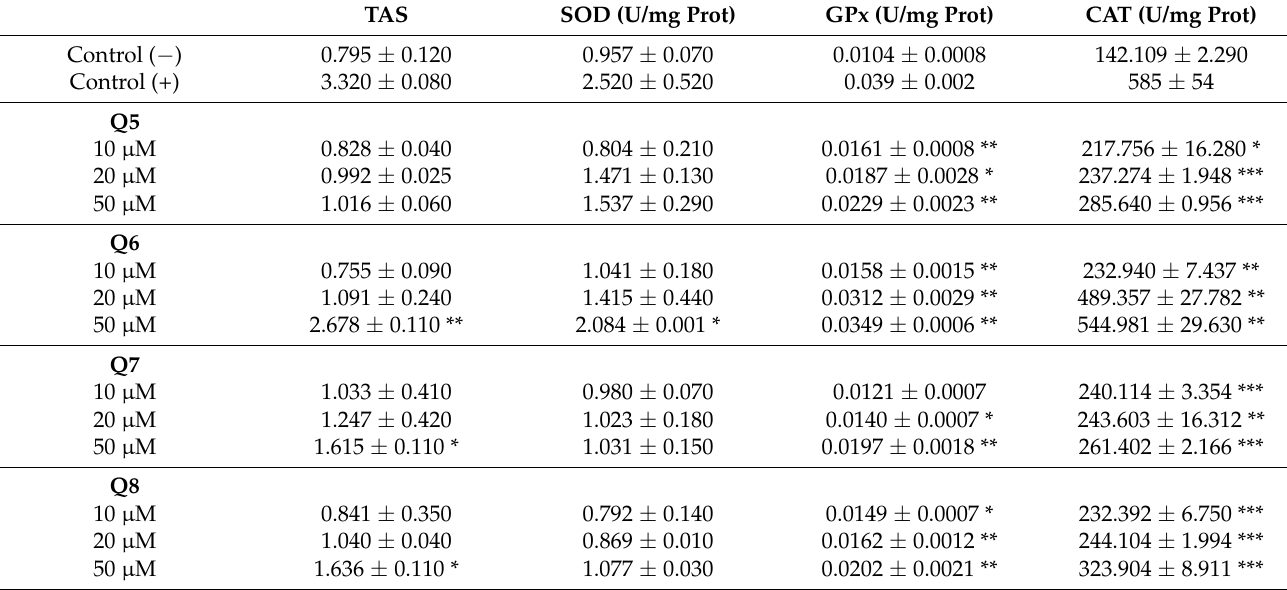
Table 2. Total antioxidant status (TAS) of selected quinazolinone derivatives, Q5–Q8, and the activity of individual enzymes—superoxide dismutase (SOD), glutathione peroxidase (GPx), and catalase (CAT) in TH-1 cells after 24 h